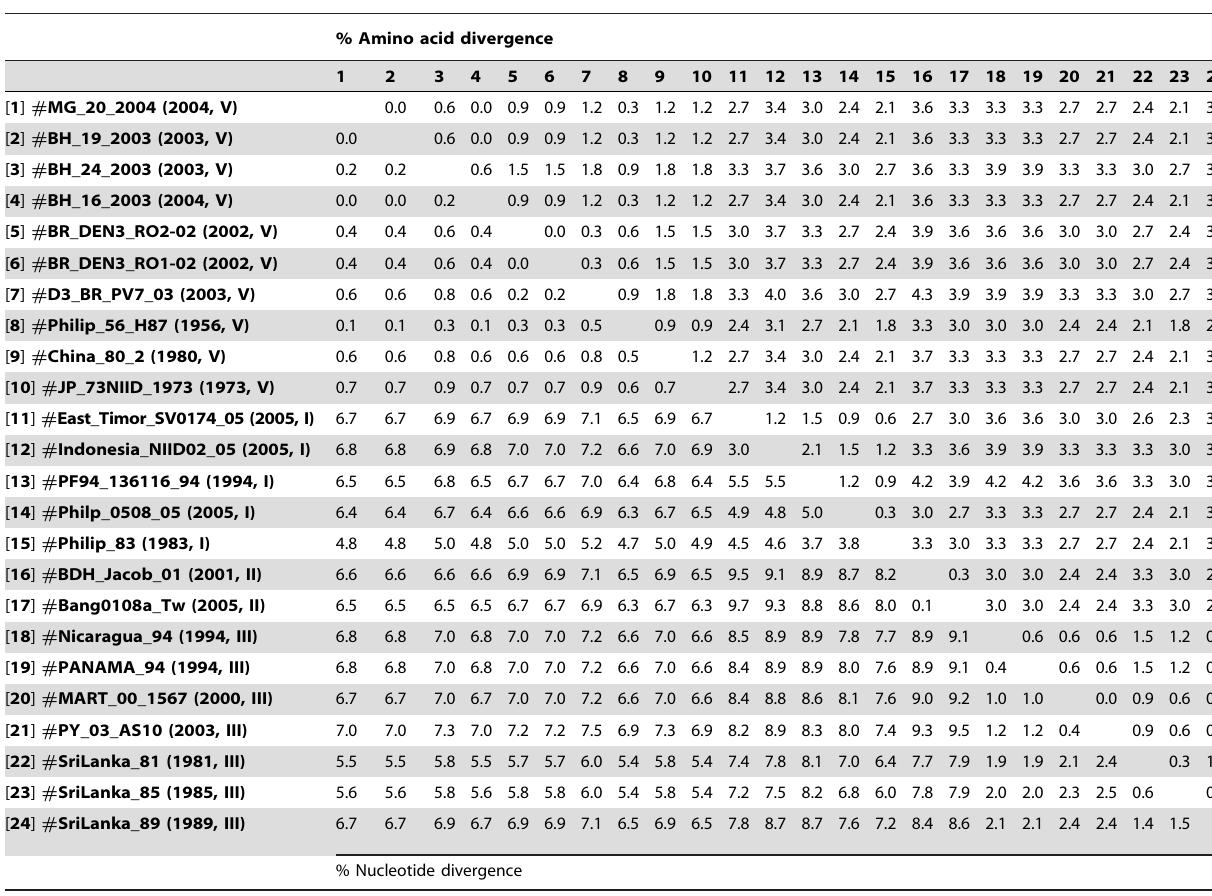
Table 1. Nucleotide and amino acid pairwise distances between DENV-3 strains used in this study for the envelope glycoprotein.